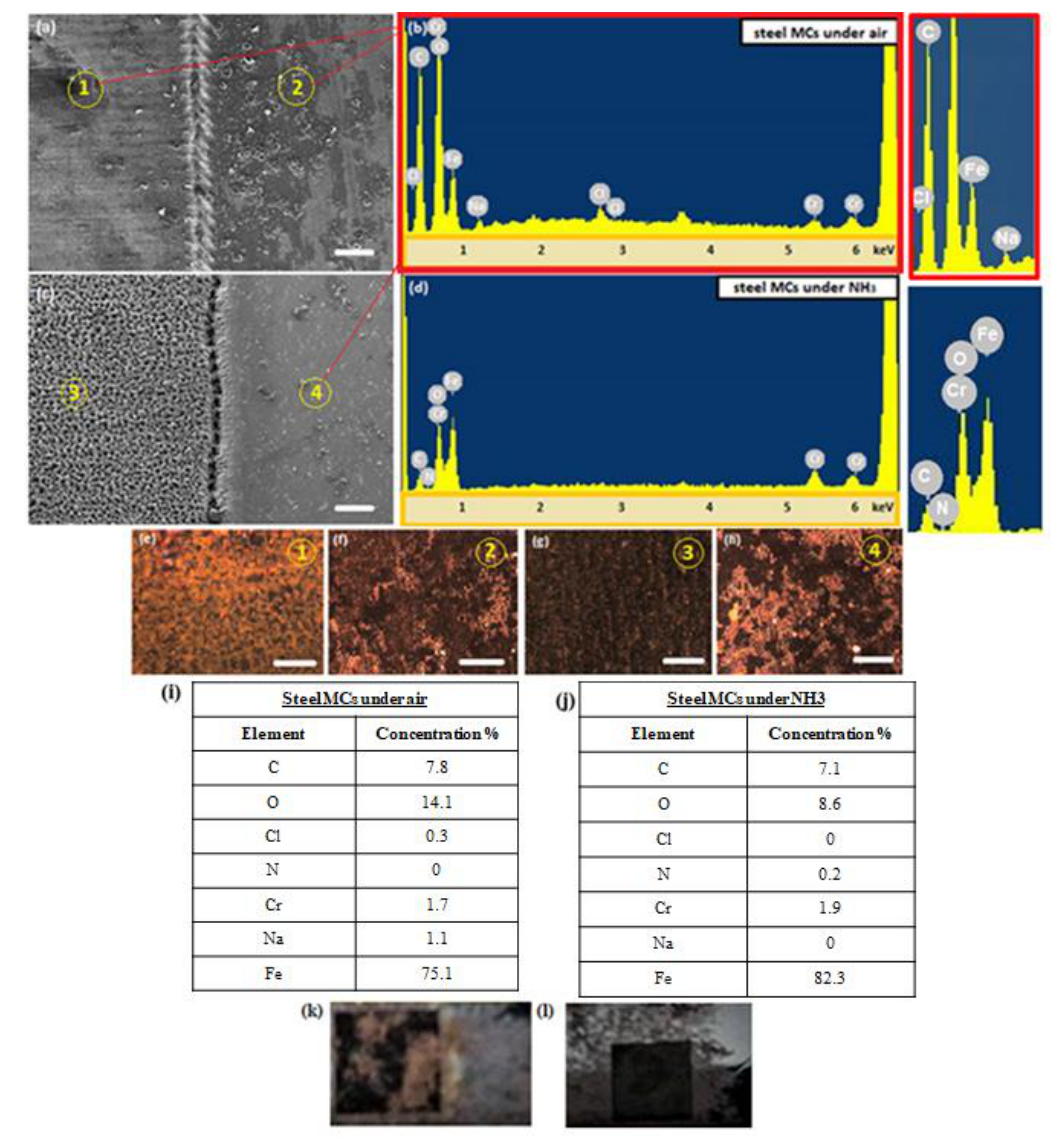
Figure 4. ( a ) Top-view SEM image of steel micro-cones (MCs) fabricated in air following the corrosion test (scale bar: 100 µ m); ( b ) EDS spectra from regions 1 and 2 shown in (a). The corresponding elemental analysis is shown in ( i ); ( c ) Top-view SEM image of steel MCs irradiated in NH 3 (scale bar: 100 µ m); ( d ) EDS spectra from region 3 shown in (c); The corresponding elemental analysis is shown in ( j ); ( e – h ) Microscope images of regions 1–4 shown in the SEM images (a,c) (scale bar: 100 µ m); Photograph of laser-treated steel sample in air ( k ) and ammonia ( l ); The black square corresponds to the structured area.